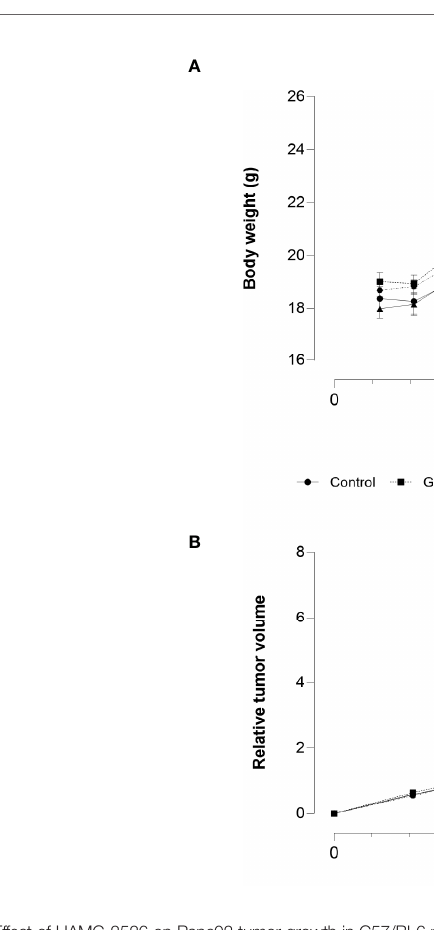
FIGURE 4 | Effect of UAMC-2526 on Panc02 tumor growth in C57/BL6 mice. Animals were injected with 4×10 6 Panc02 cells. When tumors reached an approximate volume of 150 mm 3 , mice were treated with vehicle (control), UAMC-2526, gemcitabine or a combination of UAMC-2526 and gemcitabine. Number of animals in each group was between 8-10. (A) Treatments had no effect on body weight. (B) Effects of treatment on relative tumor volumes (RTV). RTV values from D0 to D31 were examined with one-way ANOVA. Signi fi cant values of post hoc comparison were adjusted using Dunnett ’ s correction. *p ≤ 0.05, **p ≤ 0.01, ***p ≤ 0.001 versus control group. Because tumor development in the control group and UAMC-2526 treated group was too extensive, these animals were sacri fi ced at D31. RTV values of the remaining groups were examined using Welch ’ s t-test. # p ≤ 0.05 versus monotreatment with